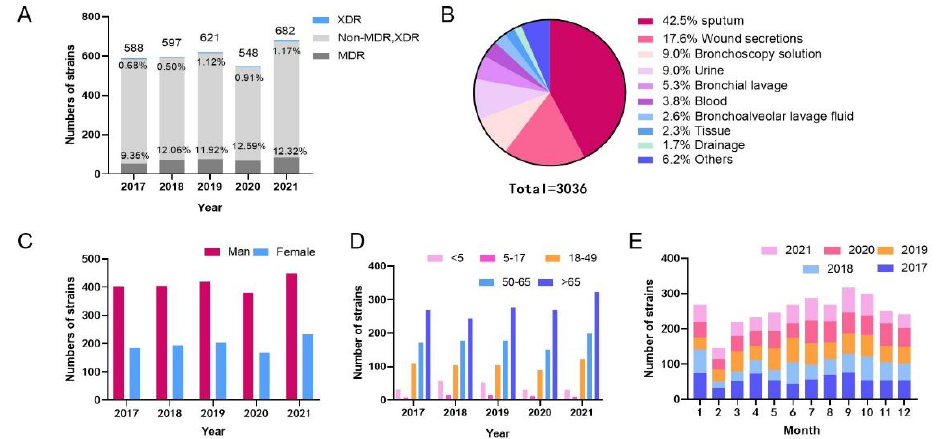
Figure 1. Distribution of 3036 P. aeruginosa strains. ( A ) Isolation of P. aeruginosa in 2017—2021, ( B ) Sample distribution, ( C ) Gender distribution of the population, ( D ) Age distribution of the population. ( E ) Time